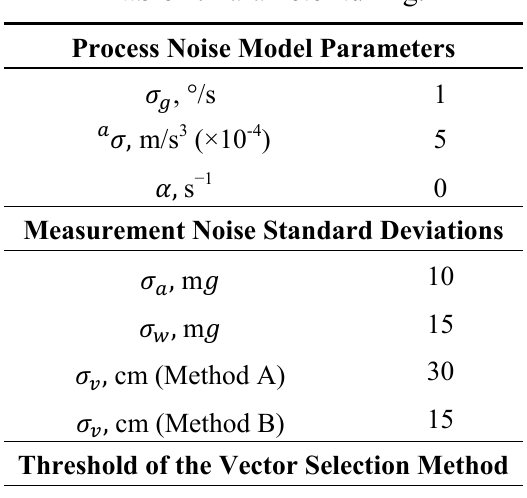
Table 1. Parameter